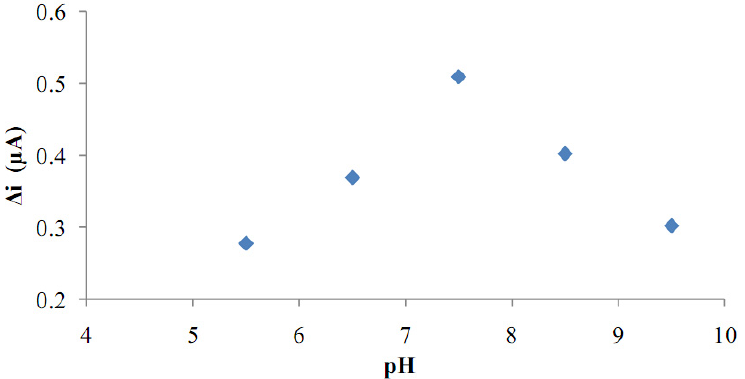
Figure 6. The effect of pH on the response of the biosensor (at 25 °C, 1.0 × 10 − 5 M glucose at 0.4 V operating